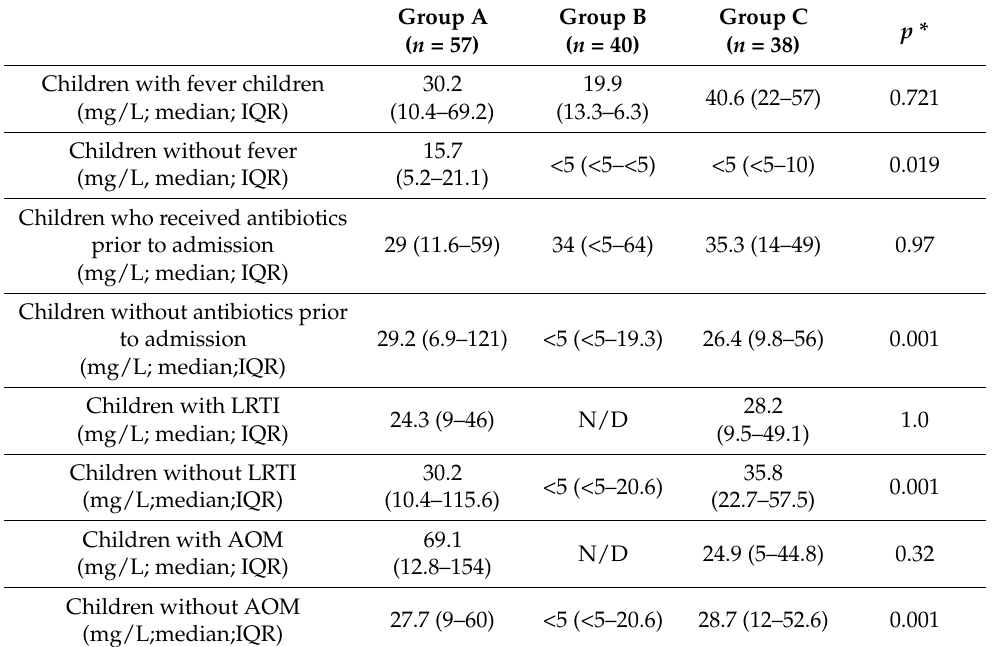
Table 4. Clinical factor module CRP levels in studied